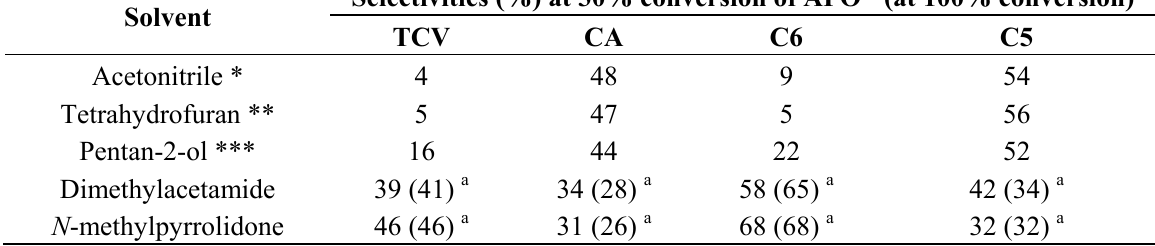
Table 5. The selectivities to trans -carveol, campholenic aldehyde, and to sum of C6 and C5 products at 30% conversion (at 100%, respectively) of α -pinene oxide over 32 wt %